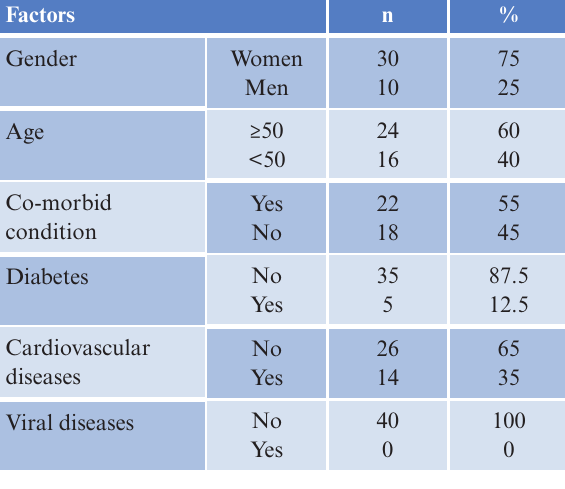
Table 1. Clinical characteristics of the kidney cancer